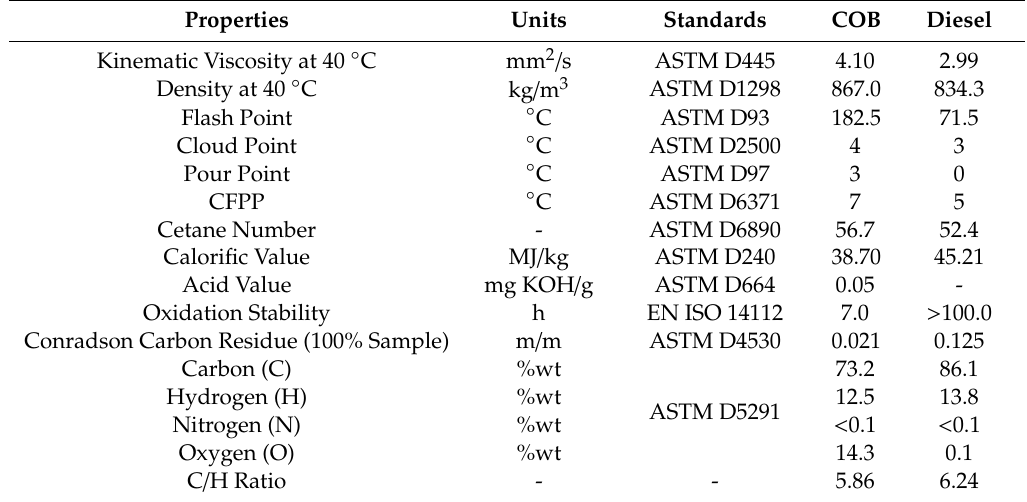
Table 1. Key physicochemical properties of the petroleum diesel and coconut oil biodiesel (COB).